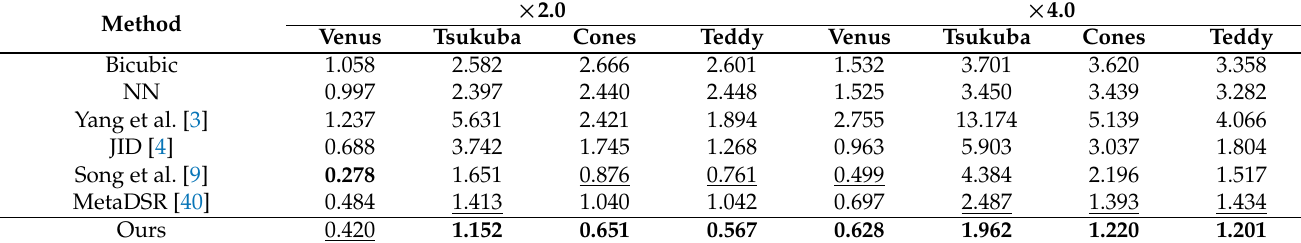
Table 2. The RMSE of upsampling factors ( 2.0 and 4.0) for different methods. We report the results of the modality × × in [40] trained with arbitrary scale factors, instead of that trained with specific scale factors. The best result is shown in bold, and the second best is underlined. For other methods, we used the RMSE given in [40] (for which lower is better). × 2.0 Method